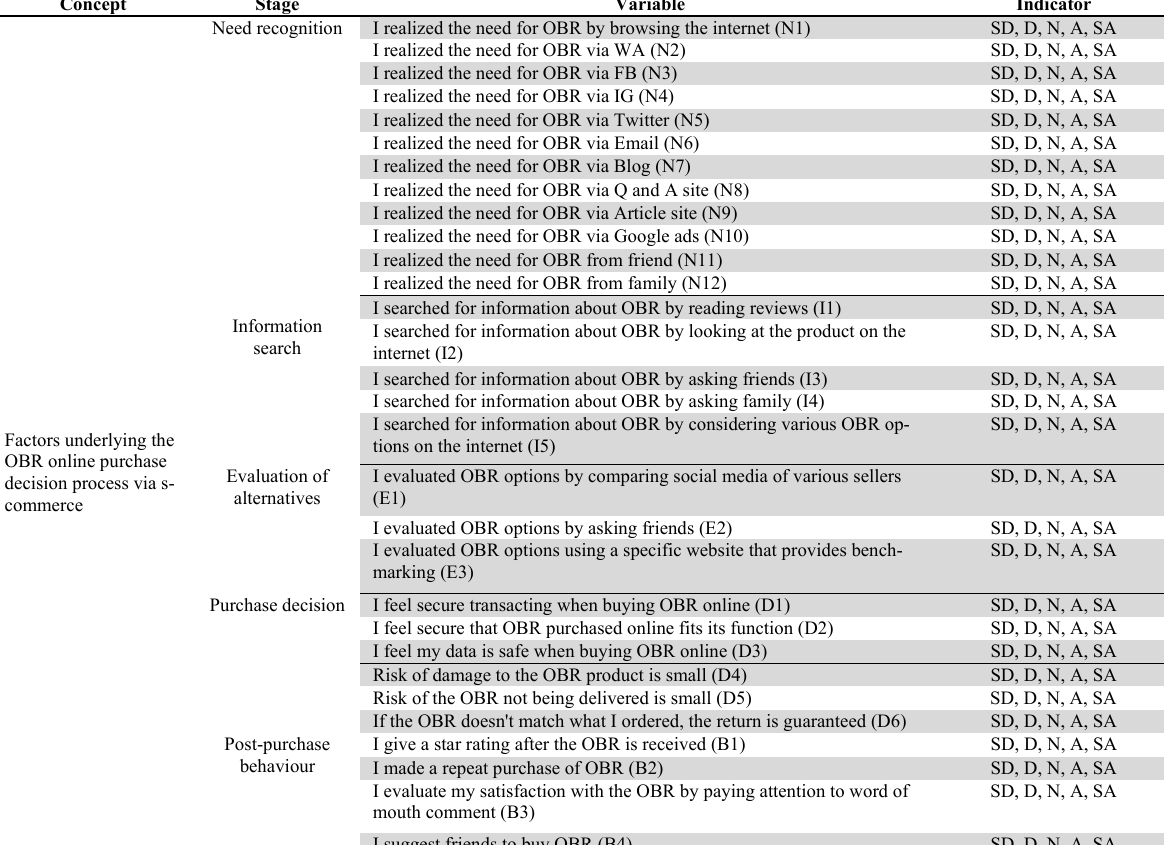
Variable and Measurement of Online Purchase Decision Process via S-commerce Concept